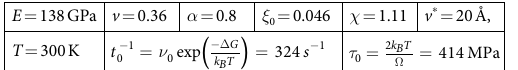
Table 1. Material parameters for MGMC 46 .